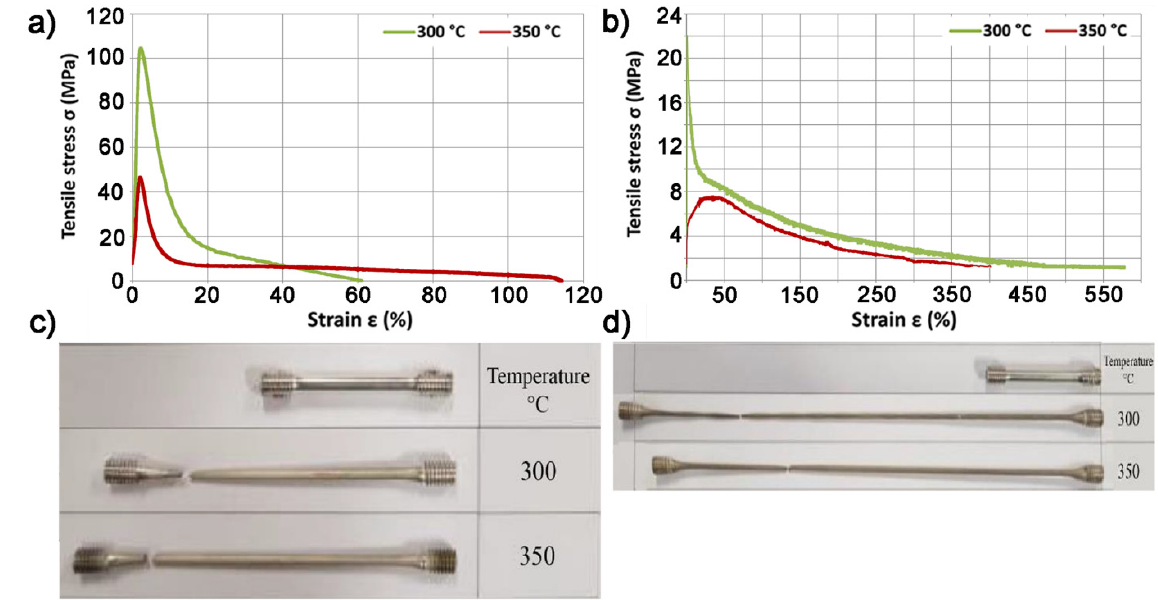
Figure 5. Representative tensile curves at 300 °C and 350 °C magnesium sand casting AZ91 (MgAl9Zn1) extruded using ( a ) the conventional method with the processing degree λ = 45 and ε = 10 − 4 s − 1 ( b ) the KOBO method with the processing degree λ = 44.4 and the die rotation frequency f = 6 Hz. A photo after a static tensile test of representative samples extruded using the method ( c ) conventional, ( d ) KOBO.